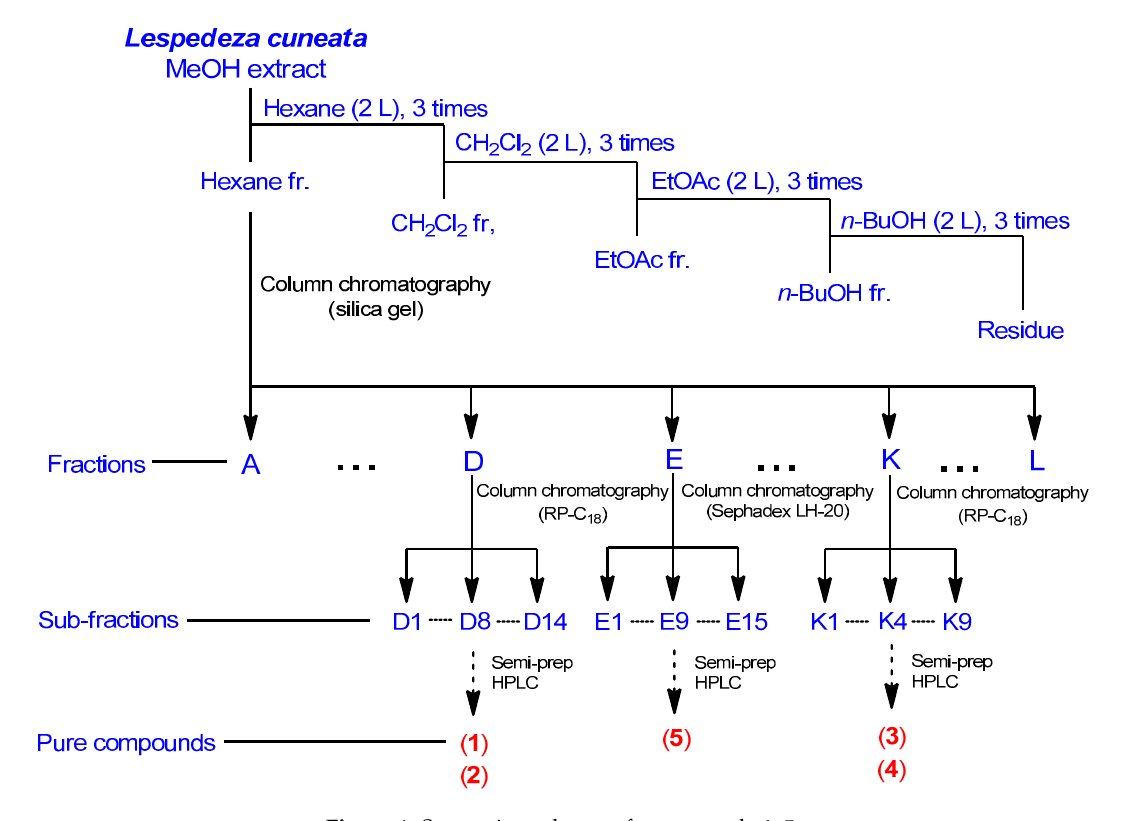
Figure 1. Separation scheme of compounds 1 – 5 .